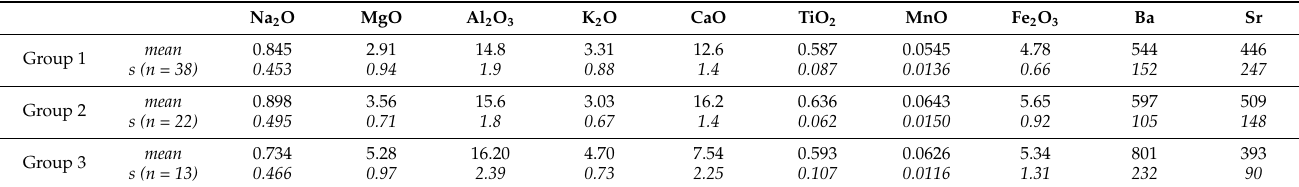
Table 1. Chemical composition of ceramic bodies, determined by ICP-OES (data as %wt, except Ba and Sr results given as µ g.g − 1 , s : standard deviation; n : number of